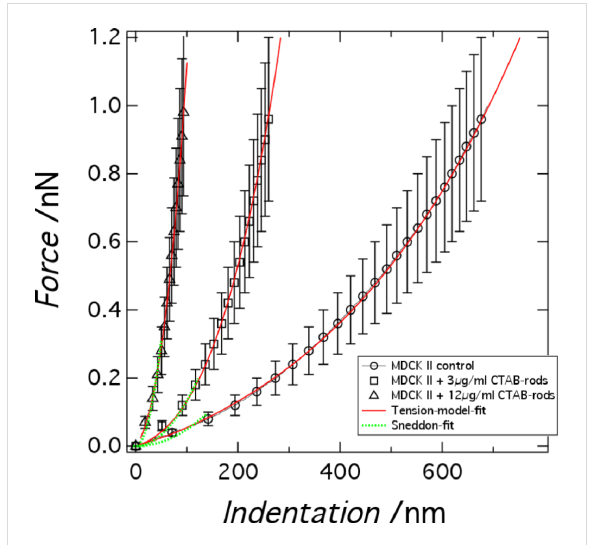
Figure 3: Mechanical analysis of confluent MDCK II cells. Averaged force indentation curves ( n > 60) obtained from indentation of confluent MDCK II cells (cell center) treated with different concentrations of CTAB functionalized gold nanospheres after 24 h of incubation (see legend). The force curves are fitted to a Hertzian contact model (green) and tension model (red) as described in the